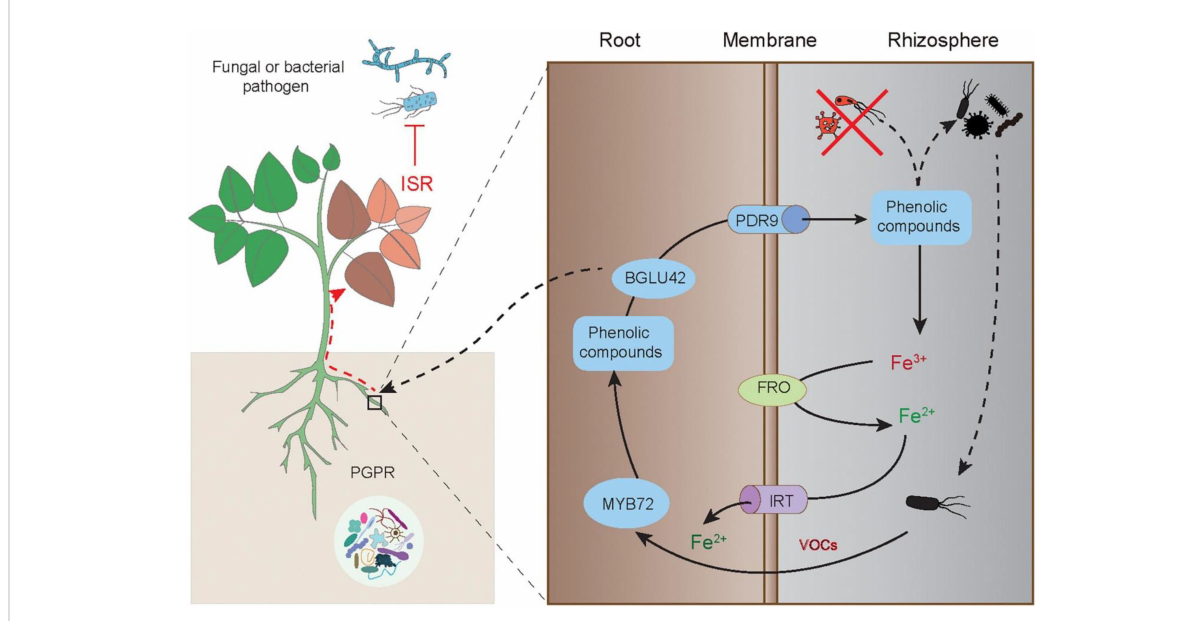
FIGURE 3 Elicitation of the MYB72-mediated ISR in plants by PGPR-released VOCs. The root-speci fi c gene MYB72 initiates the ISR and Fe uptake in plants induced by PGPR. The ISR-eliciting PGPR can activate the expression of MYB72, which controls the biosynthesis of fl uorescent phenolic compounds, and the expression of BGLU42 encoding the glucose hydrolase gene and PDR9 encoding the ABC transporter gene, thereby triggering root exudation of phenolics. The root-released phenolics further promote the mobilization of Fe 3+ and make it available for reduction and uptake by plant roots. The phenolics can also shape speci fi c rhizosphere microbiota. Moreover, the MYB72-dependent BGLU42 activity is essential for stimulating the ISR responses. This fi gure is acknowledged by Verbon et al.